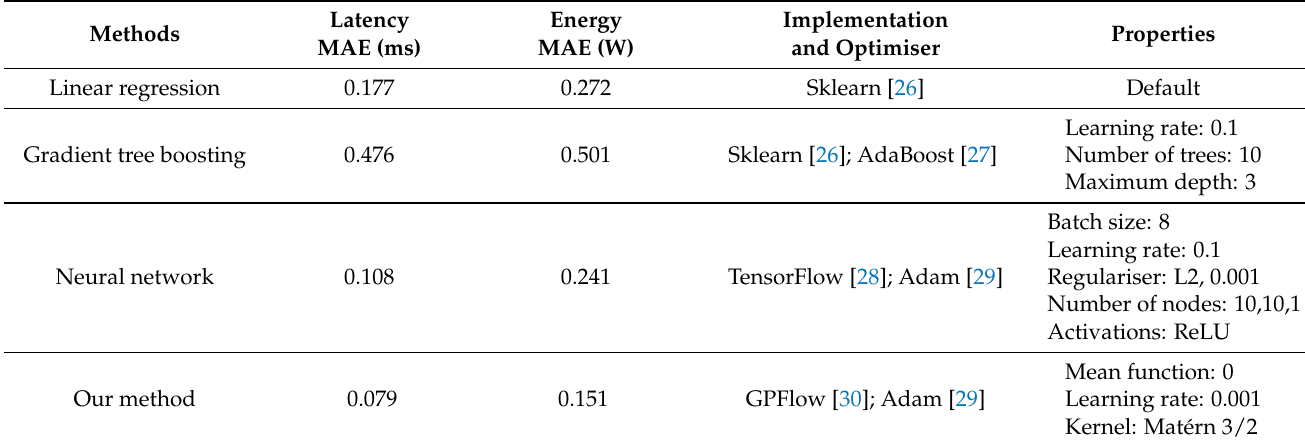
Table 6. Evaluation of network-wise latency and energy estimation for different methods on the convolutional neural network accelerator on an